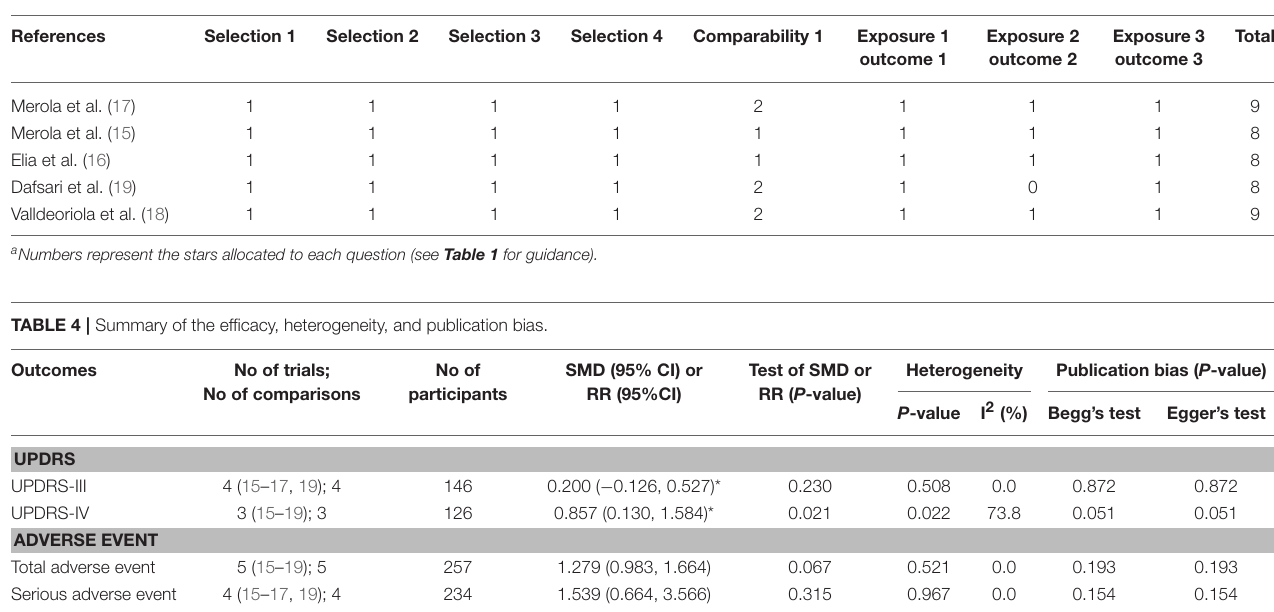
TABLE 3 | Quality assessment of observational studies on advanced treatment of PD a .